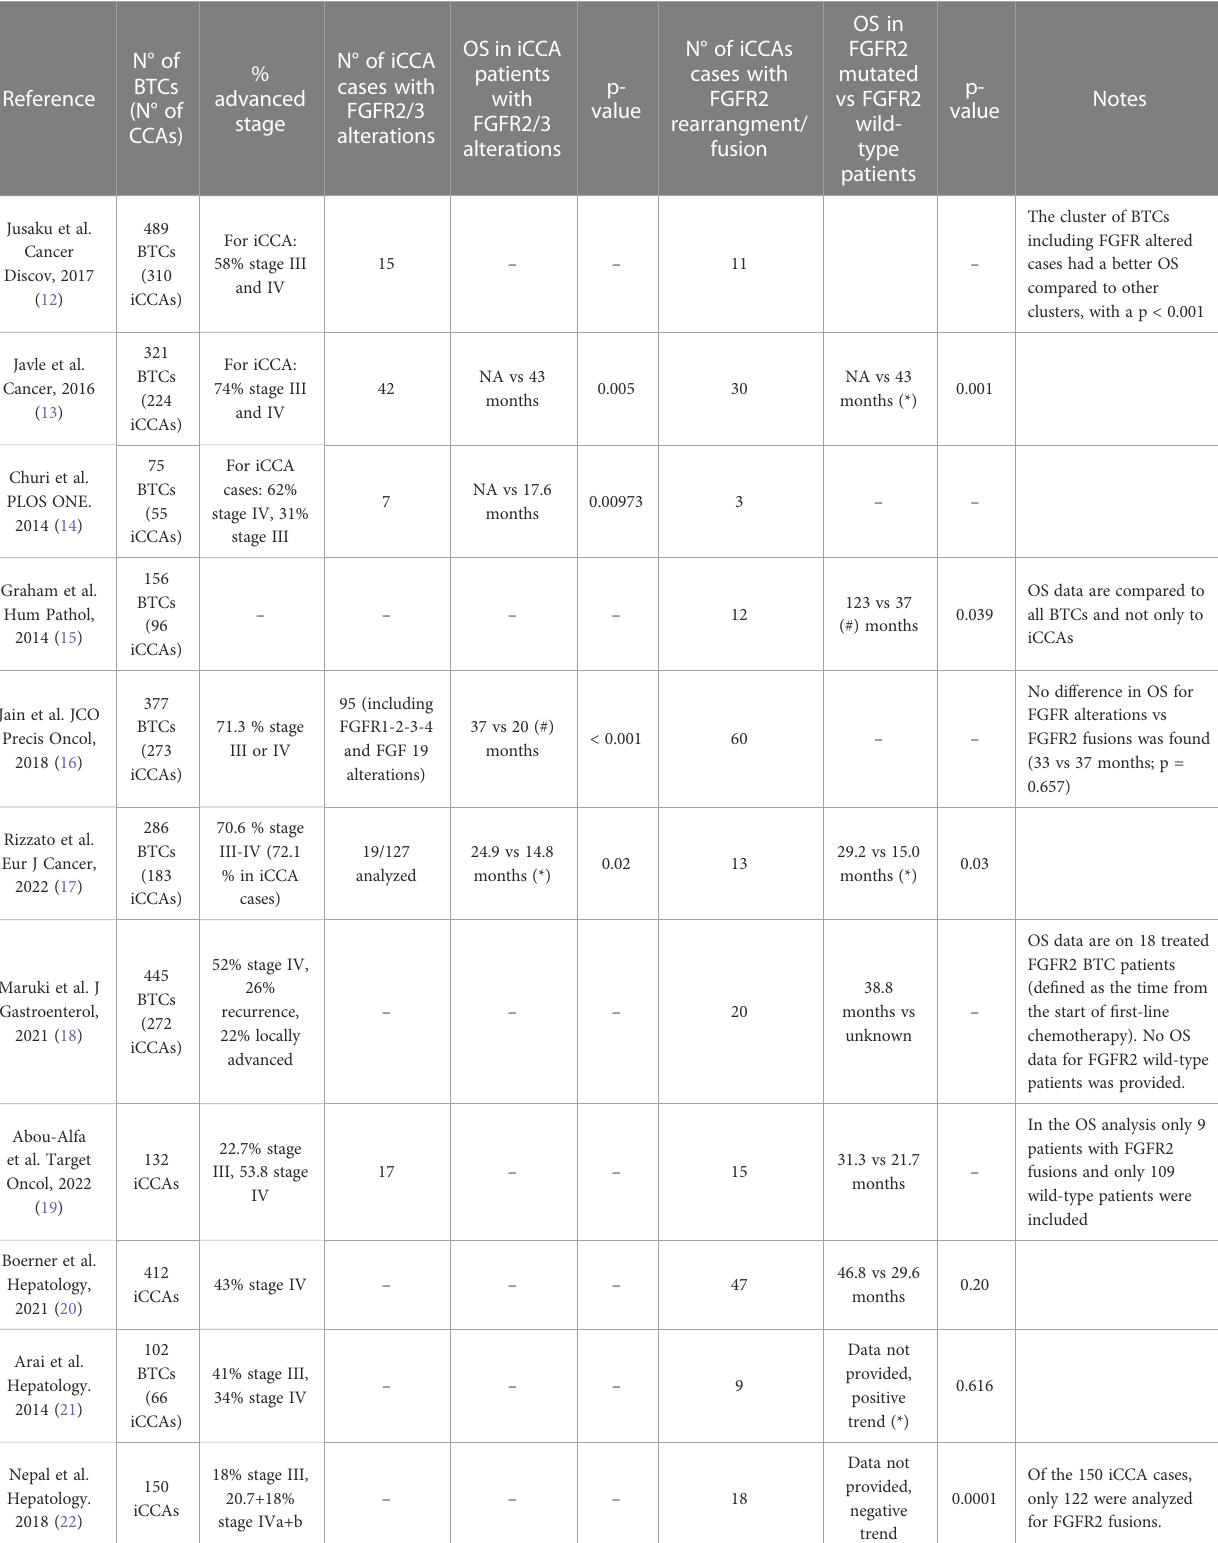
TABLE 1 OS in FGFR2/3 altered and OS in FGFR2 rearranged patients compared to OS in iCCA (*) or Biliary Tract Cancer BTC (#) cases.